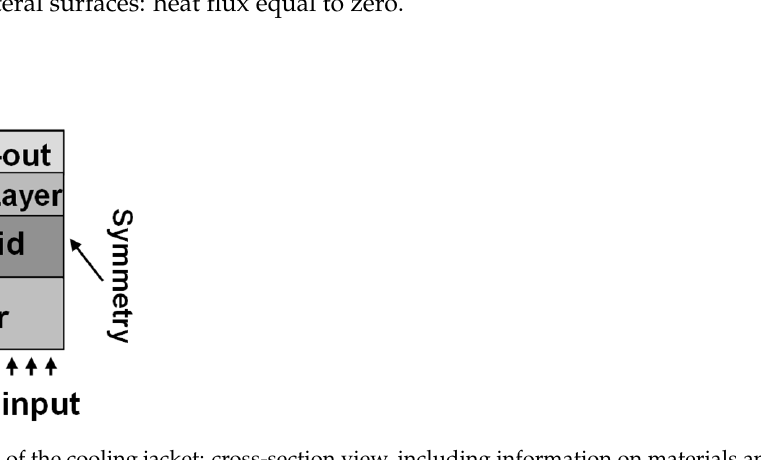
Table 2. Results of grid-independence